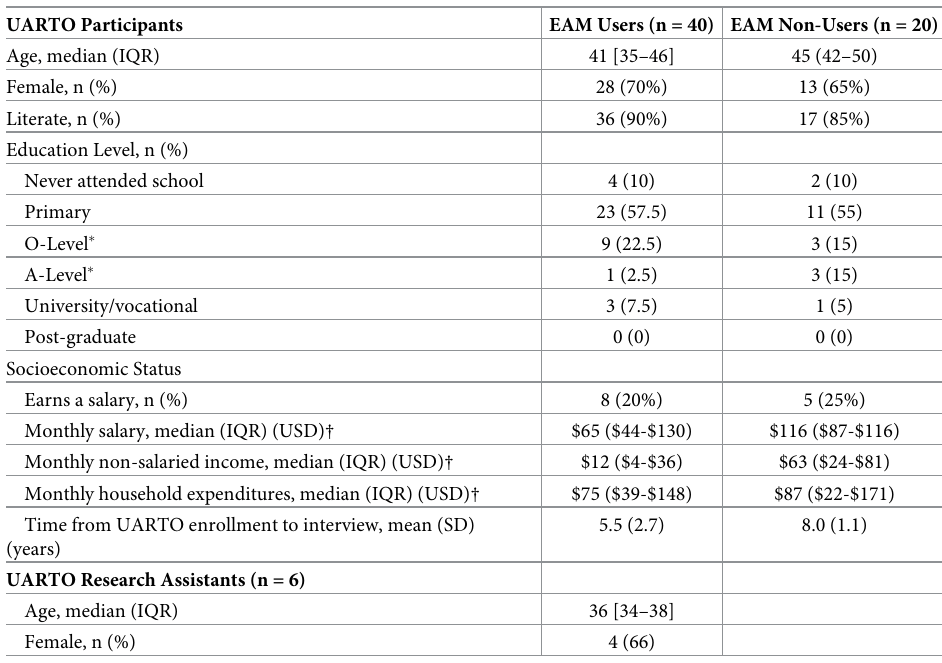
Table 1. Participant characteristics.